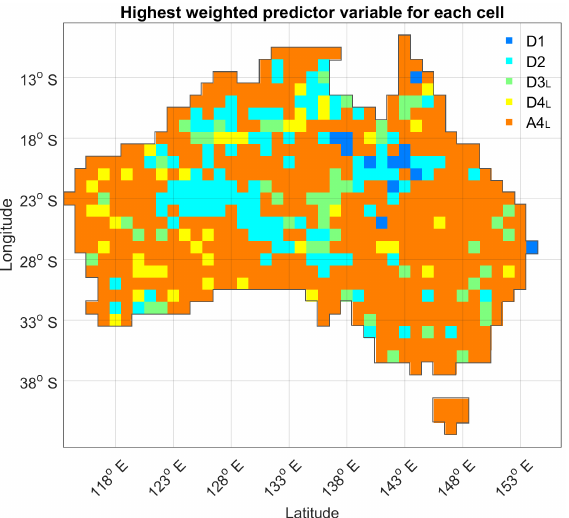
Figure 7. The variable with the highest relative weight in the re- gression for each cell across Australia. A 4 is the most dominant; however D 2 is prominent in distinct areas throughout central Aus- tralia. D 1, D 3 L , and D 4 L all occur but with little spatial coherence.